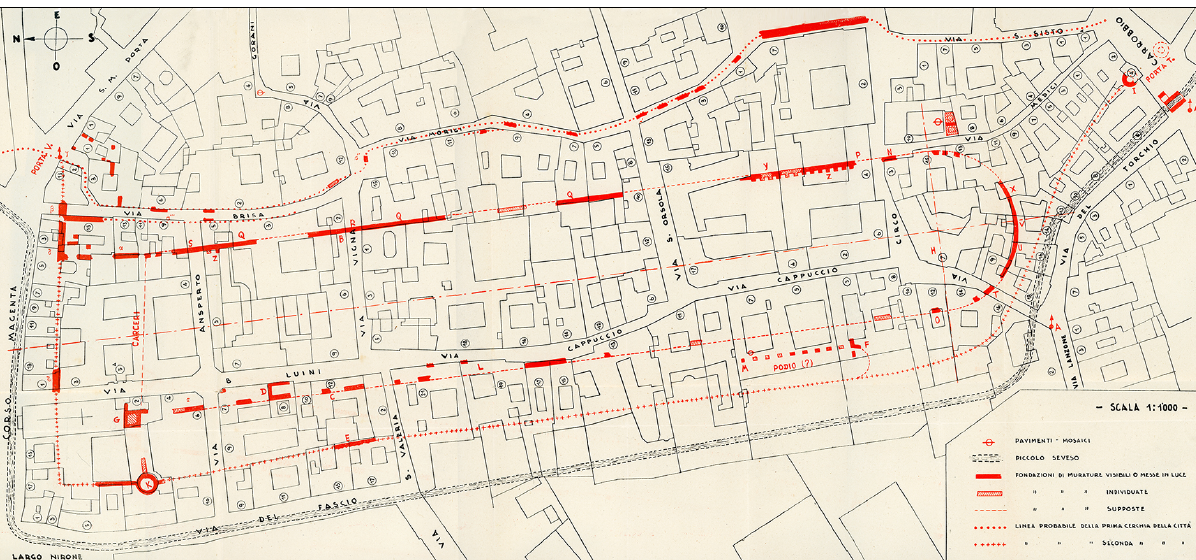
Figure 2. Plan of Milan Circus according to archaeological studies conducted by De Capitani D'Arzago (Capitani D'Arzago, 1939). Legend: full red pattern: foundations of visible walls or put into light; obliquely red dashed line pattern: identified masonry foundations; red dashed lines pattern: supposed masonry foundations.